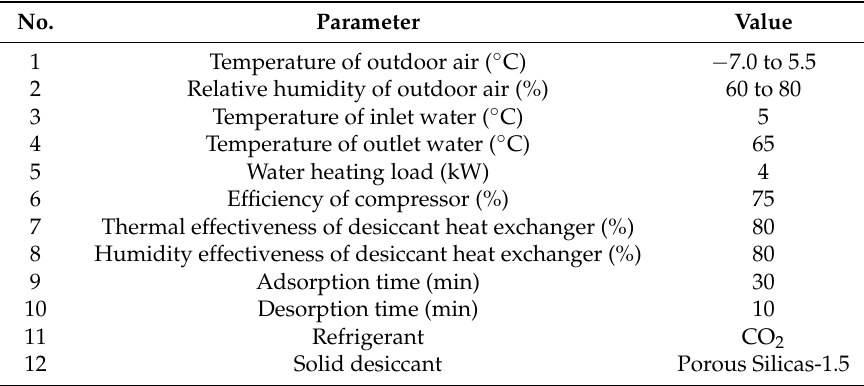
Figure 16. Schematic diagram of the FFASHP water heater system based on solid desiccant [83]. Table 9. Parameters of the numerical calculation [83].